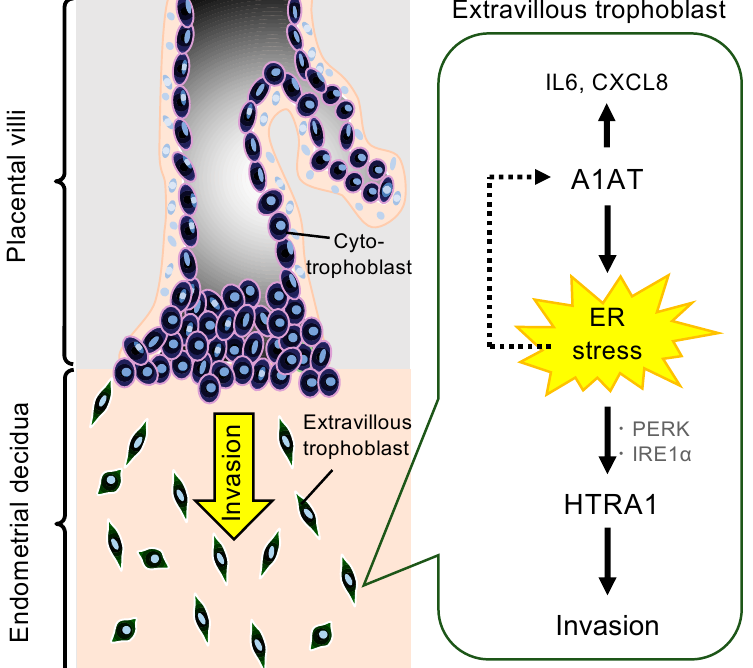
Figure 4. Diagram illustrating the proposed mechanism linking A1AT and invasion by extravillous trophoblast cells. Abnormal A1AT expression induces ER stress, which leads to the upregulation of HTRA1 and results in invasion by trophoblast cells. ER stress increases A1AT expression. In addition, A1AT stimulates IL6 and CXCL8